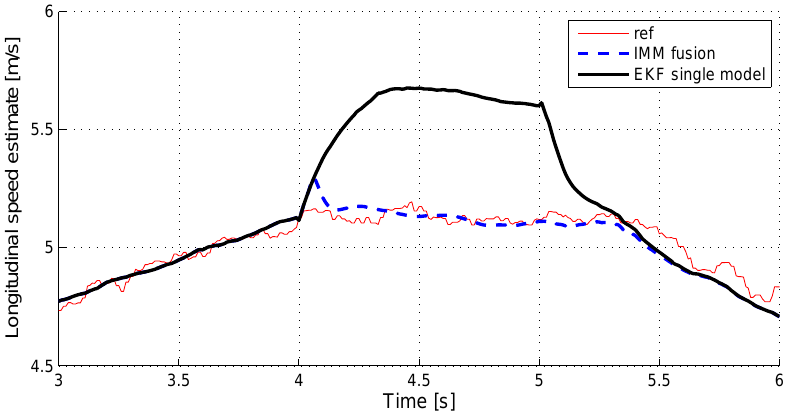
Figure 9. Longitudinal speed estimate with X-acceleration sensor